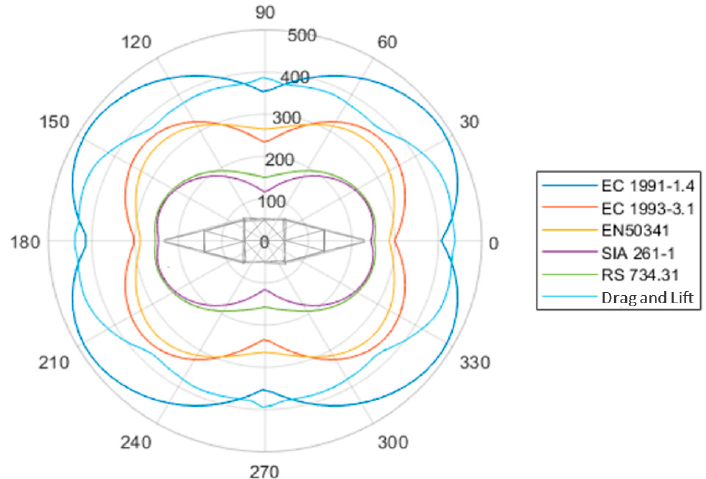
Figure 20. Polar plot of the total lateral forces (in kN, sum of both total wind load on the lattice structure and resultant force from the wind on the cables) according to different standards and depending on angle of attack (deg, 0° in transverse direction).